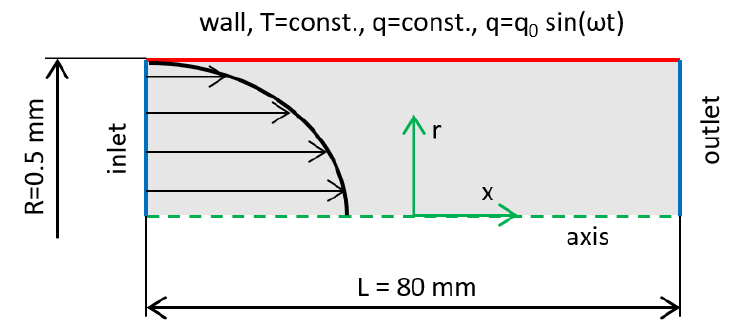
Figure 2. A simplified drawing of the 2D numerical model with boundary conditions. The input boundary condition is a velocity profile using a UDF (user-defined function) and corresponds to a parabolic velocity profile. The upper boundary condition varies according to the task.